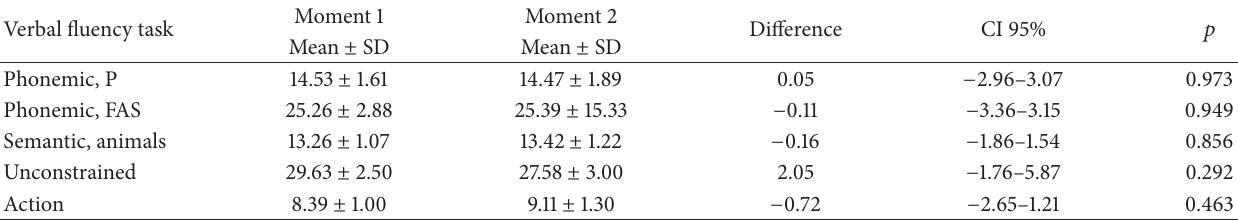
Table 3: Comparisons of verbal fluency tasks between moments of administration.